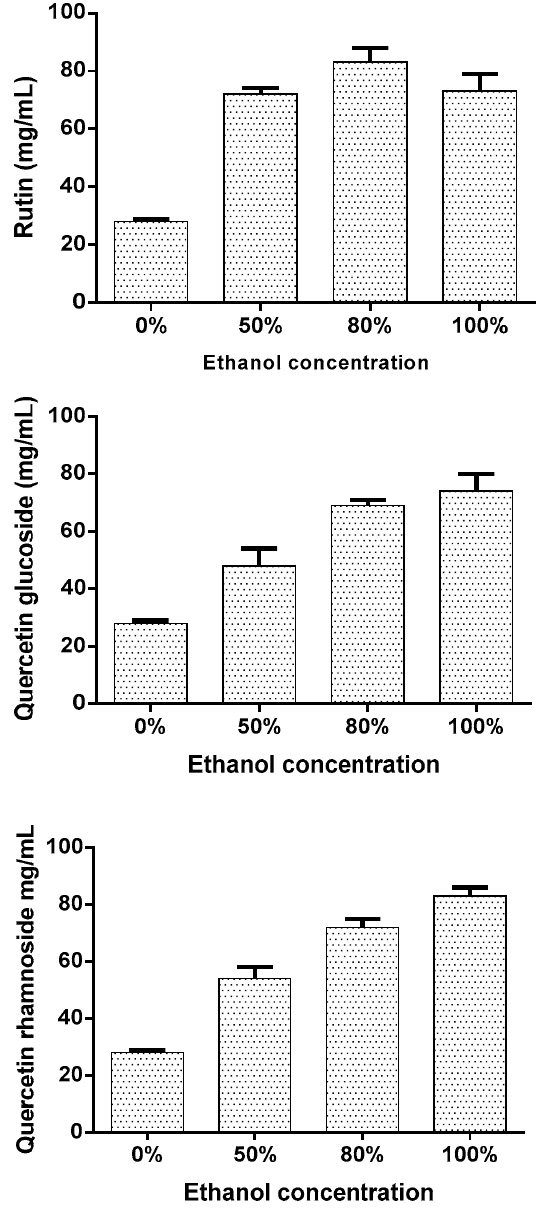
Figure 3. Flavonoid determination. The yield of rutin, quercetin glucoside and quercetin rhamnoside in di ff erent ethanol extracts was determine. Individual samples of B. x buttiana extract ethanol 0%, 50%, 80%, and 100% were investigated to determine the yield of rutin as described in Materials and Methods. Each bar corresponds to the results (mean ± standard deviation (SD)) from three di ff erent preparations.